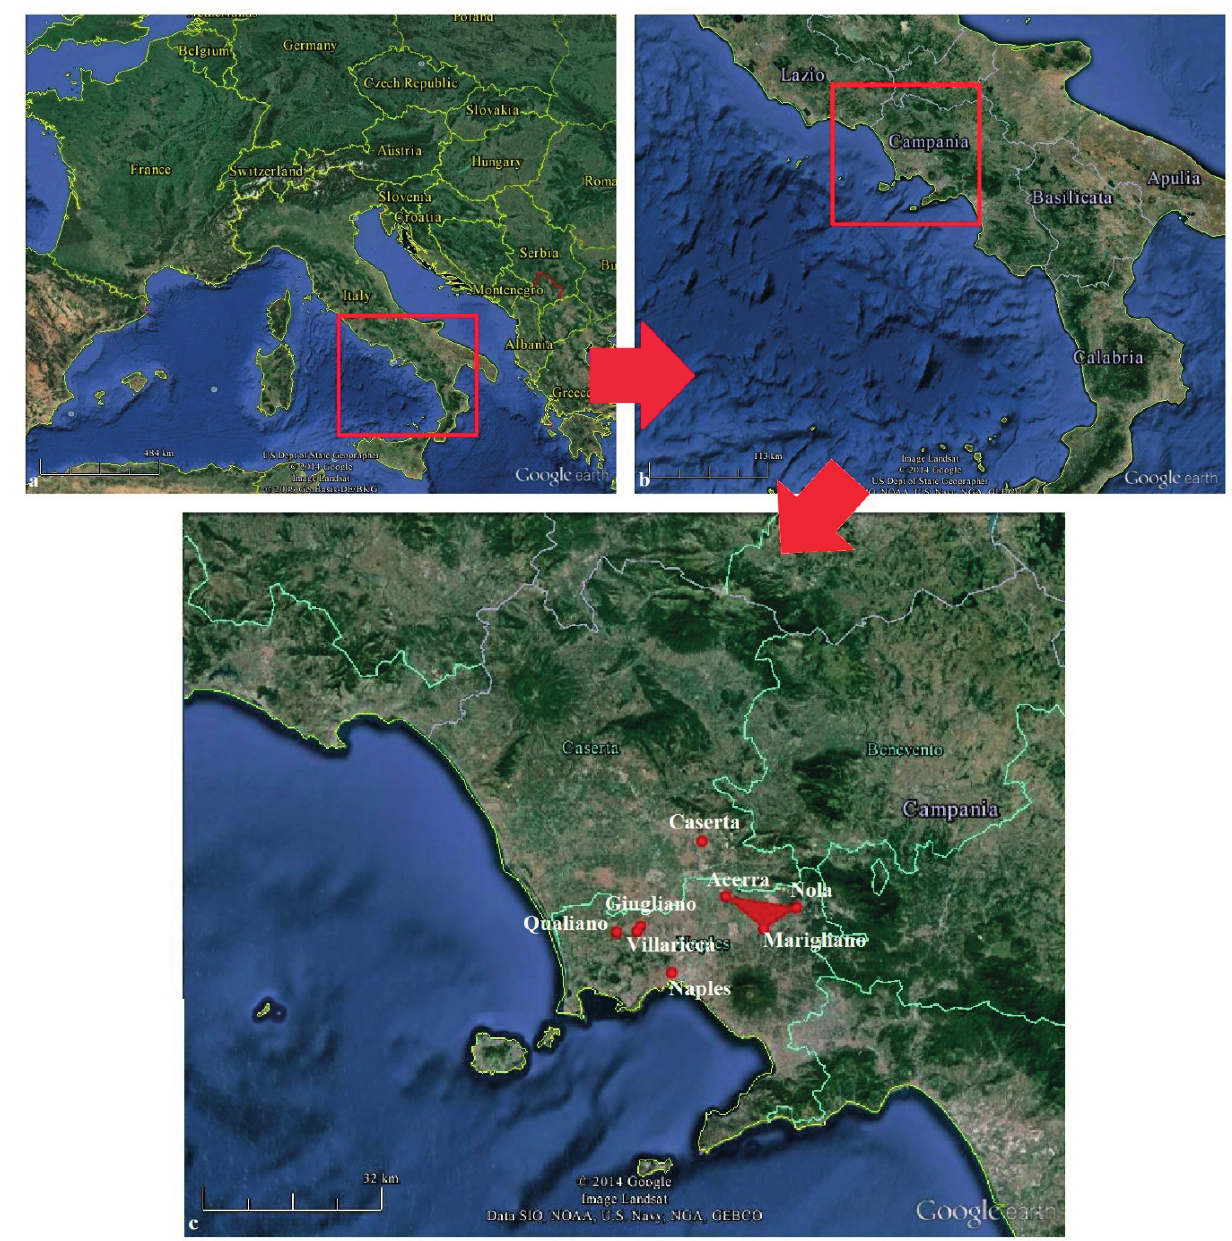
Figure 1. Maps of the study area. ( a ) Italy; ( b ) Campania Region (southern Italy); ( c ) Location of main municipalities under study in southern part of Caserta Province and in the northern part of Naples Province, including the “triangle of death” marked with